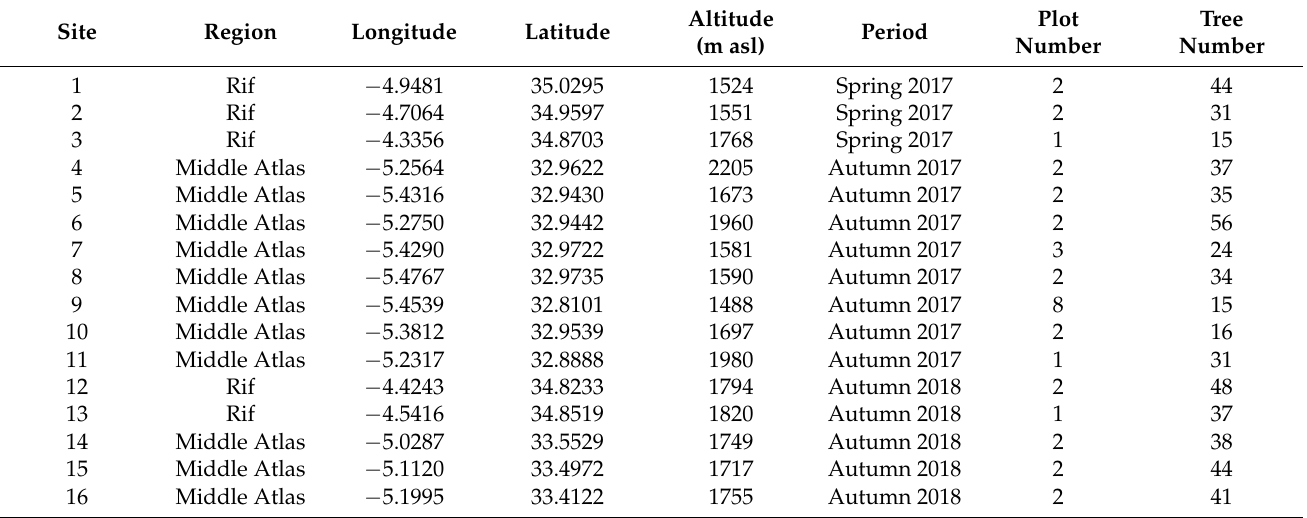
Table 1. Location, altitude, sampling period, numbers of covered plots and of sampled